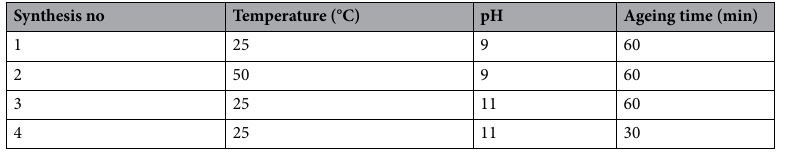
Table 1. Experimental conditions for the synthesis by chemical precipitation from two aqueous solutions of